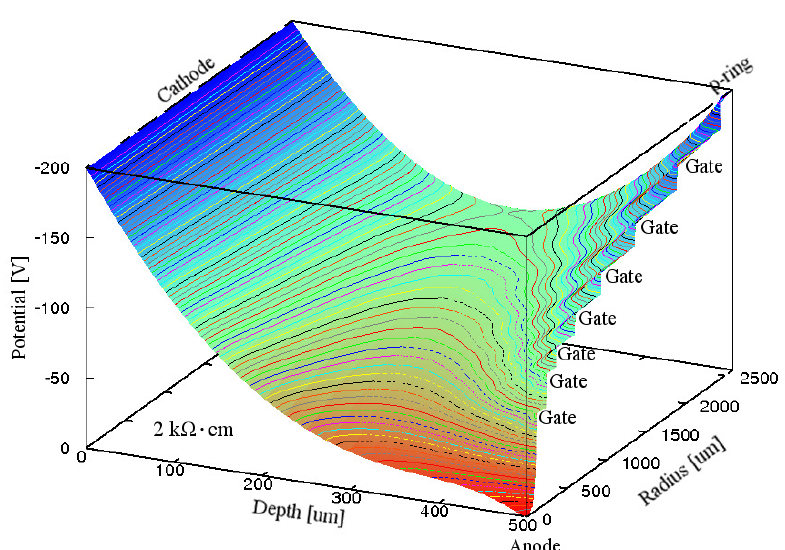
Figure 5. Simulated electric potential distribution in the Si substrate inside the p-ring of a 0 . 5 -mm-thick GSDD with R of 3 . 5 mm and ρ of 2 k Ω · cm for Gate B. A reverse bias chip Si voltage of − 200 V was applied to the cathode, p-ring and seven gates. Equipotential lines are shown at 2 . 5 V